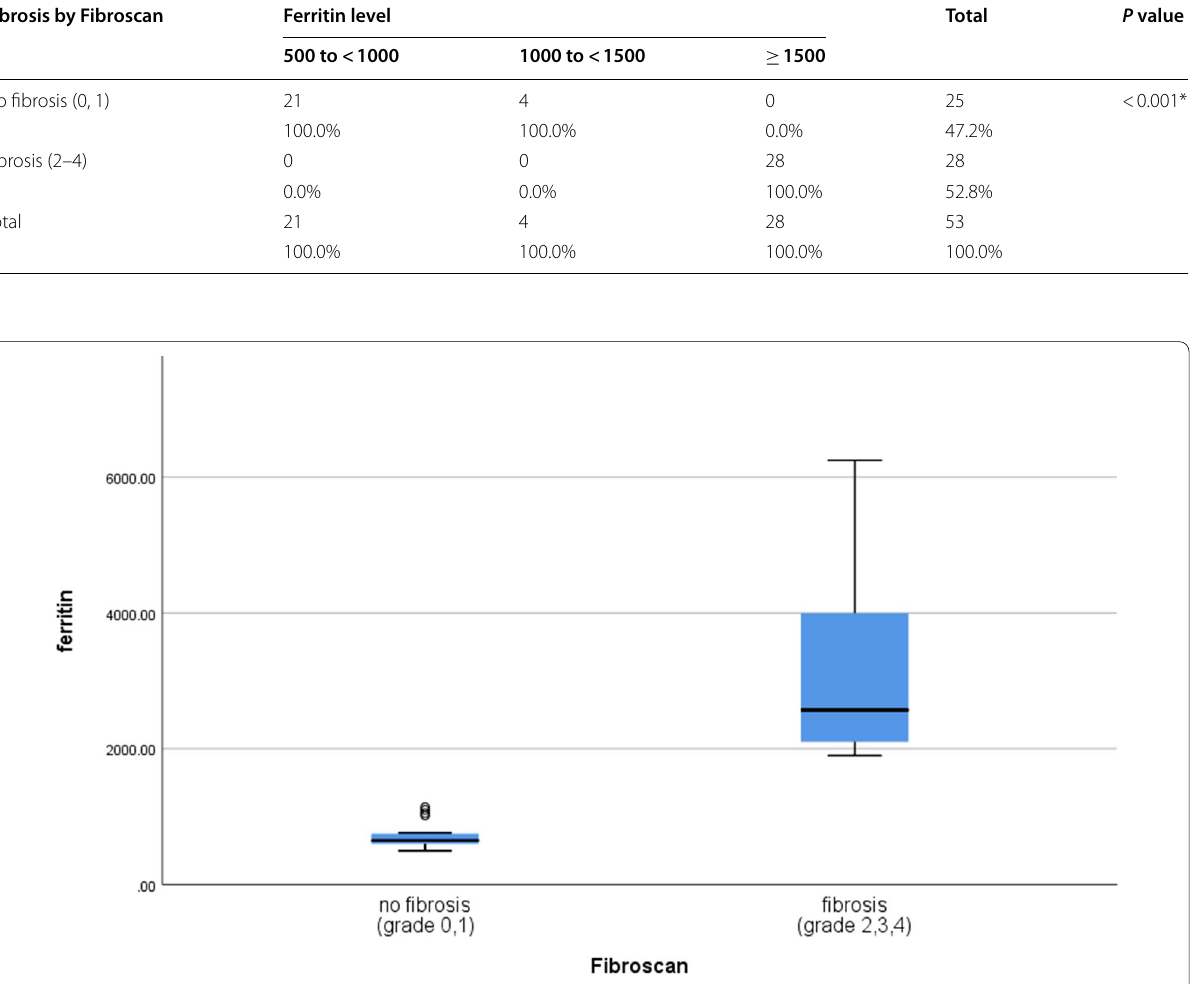
Fig. 1 Comparison between patients with fibrosis and patients without fibrosis regarding the ferritin